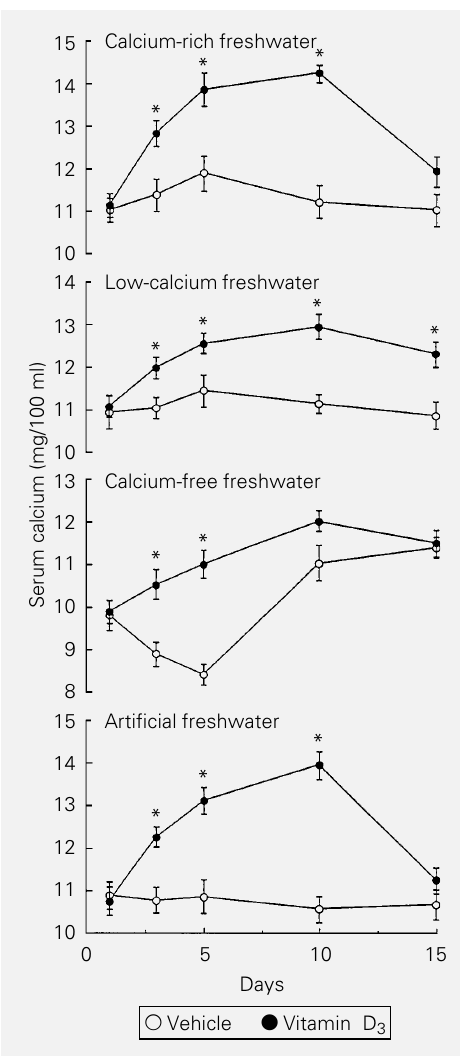
Figure 1 - Changes in serum cal- cium levels of A. cuchia kept in artificial freshwater, calcium-free freshwater, low-calcium fresh- water or calcium-rich freshwater and treated with vehicle or vita- min D 3 . Each value represents the mean ± SEM for six speci- mens. Asterisk indicates signifi- cant differences (P<0.05) com- pared to the vehicle-injected group (Student t